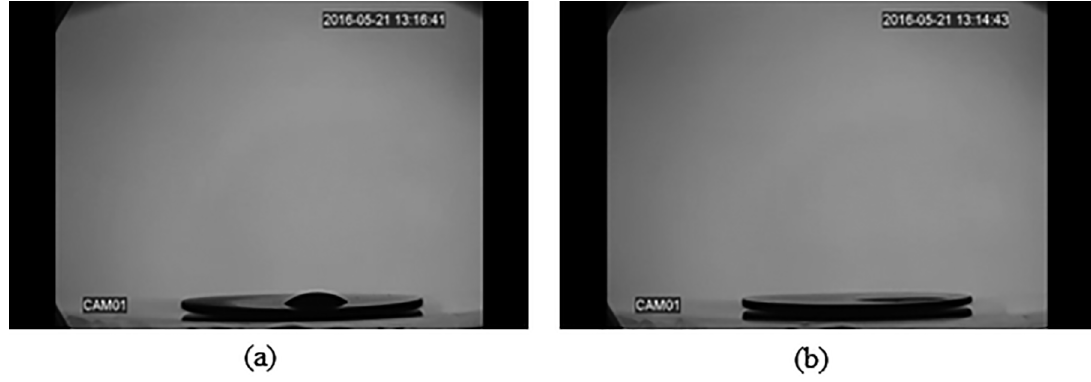
Figure 3. Wettability test of titanium surfaces. (a) treated in 3 hours, (b) treated in 8 hours.